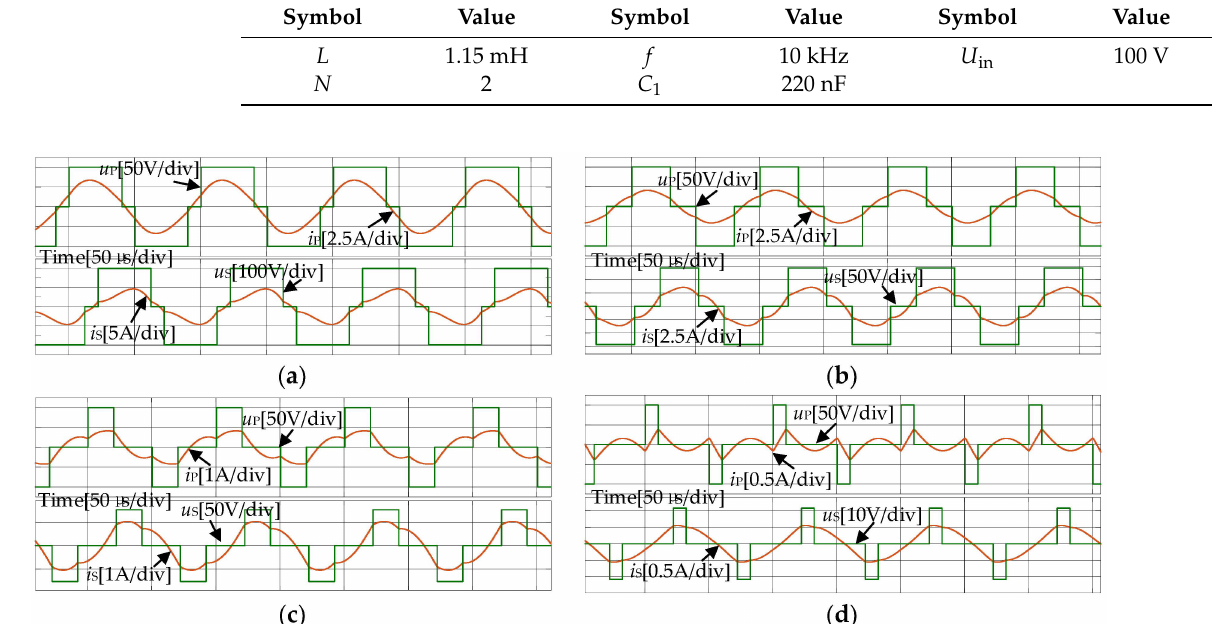
Figure 10. The steady-state simulation waveforms: ( a ) d 1 = 0.1; ( b ) d 1 = 0.2; ( c ) d 1 = 0.3; ( d ) d 1 = 0.4.